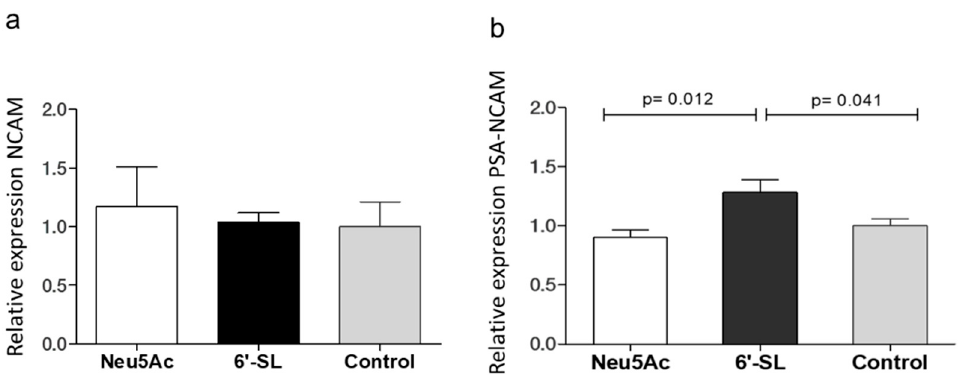
Figure 2. Relative protein expression of NCAM ( a ) and PSA-NCAM ( b ) in frontal cortex samples of rat pups of the three experimental groups at Postnatal Day 22. One-way ANOVA and Student’s t -test were used for statistical analysis. Data are expressed as the mean ± SEM ( n = 6 rats/group), p < 0.05 denotes significant differences. NCAM, neural cell adhesion molecule; PSA-NCAM, polysialylated-neural cell adhesion molecule; Neu5Ac, N-acetylneuraminic acid; 6 ′ -SL, 6 ′ -sialyllactose.